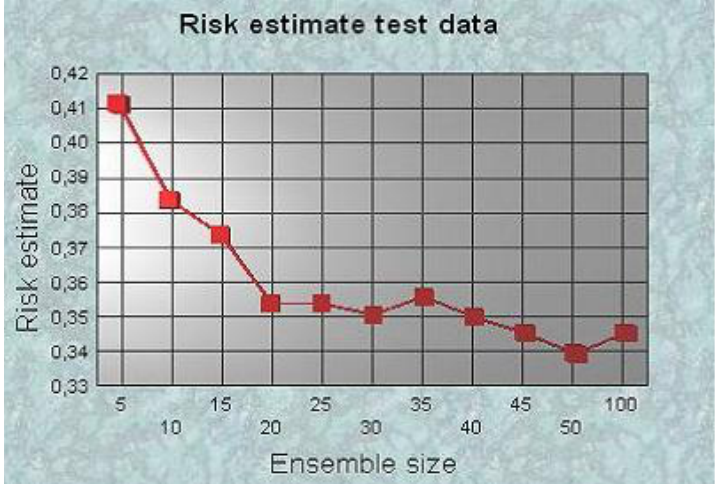
Figure 3: Relationship between ensemble size and risk estimate for test data